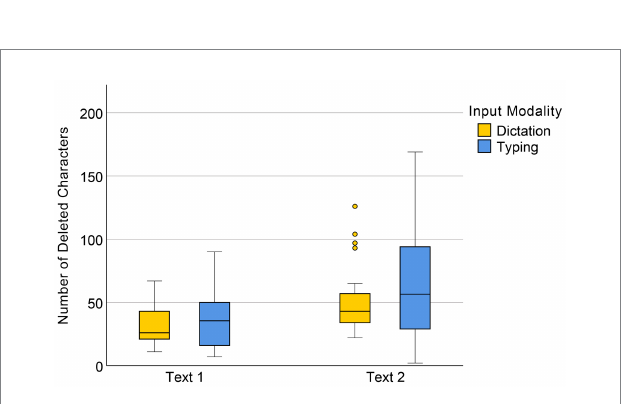
FIGURE 6 Numbers of deleted characters in dictation and typing conditions.